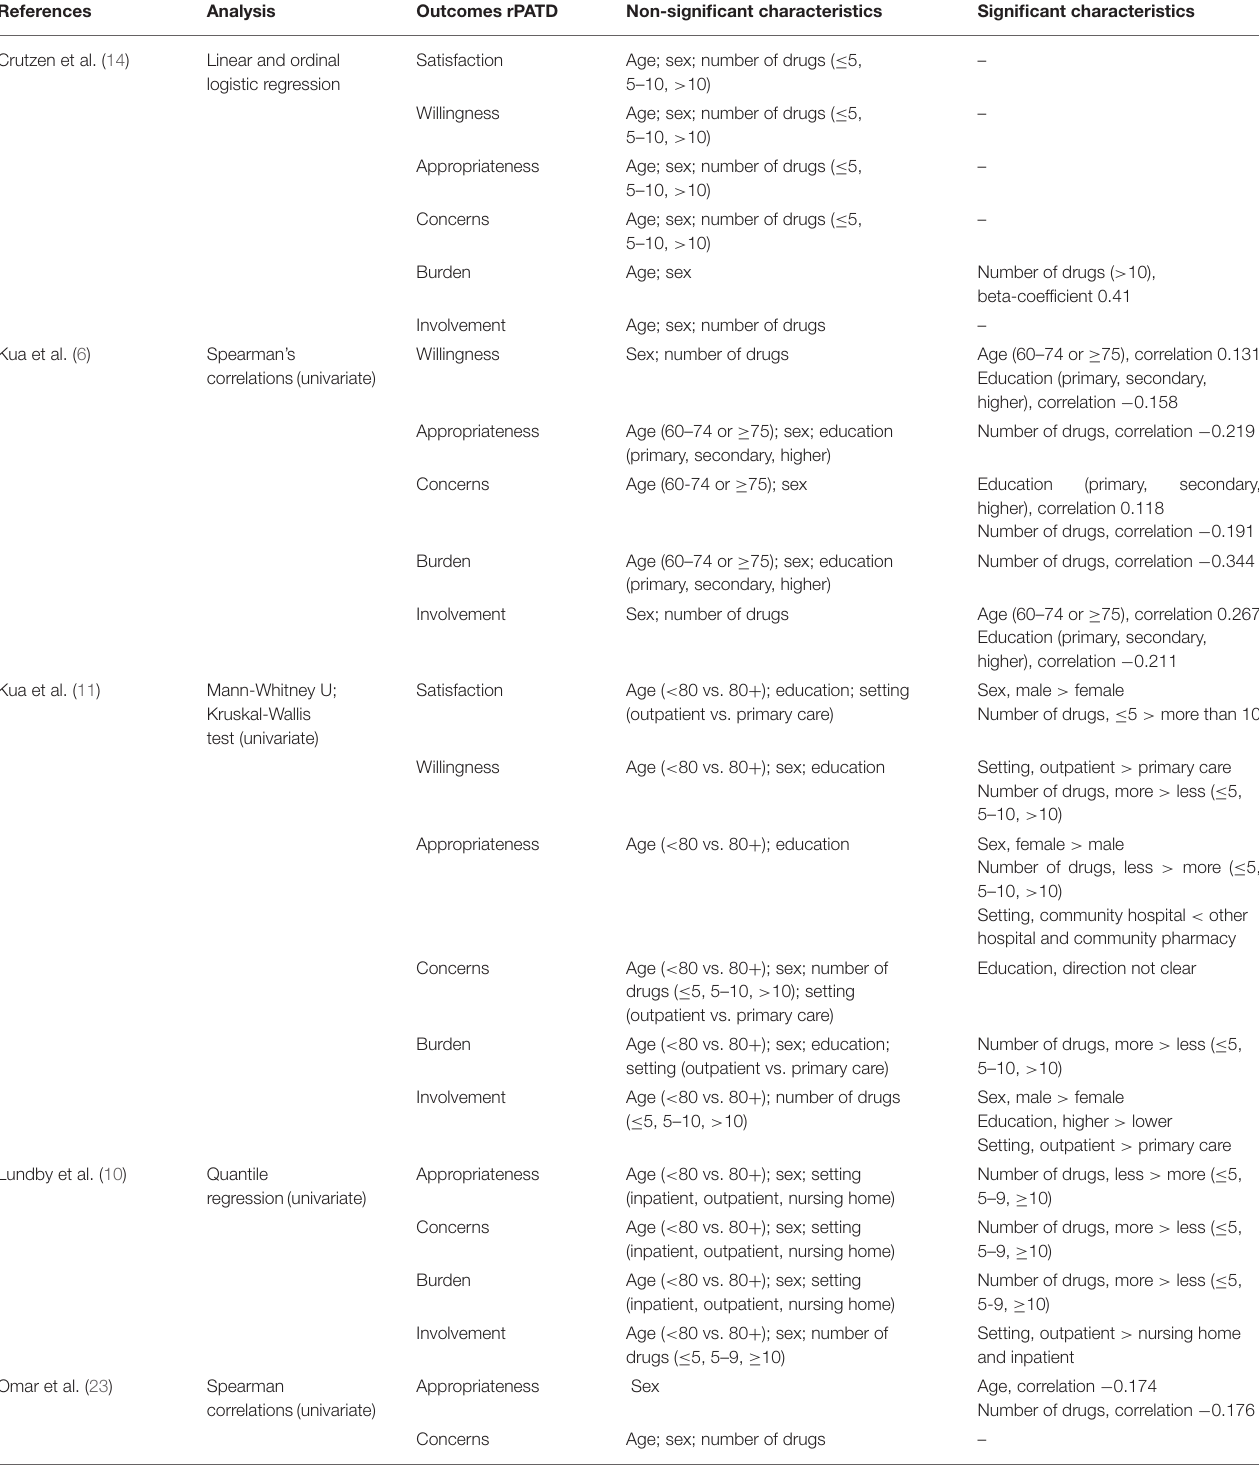
TABLE 1 | Characteristics associated with the two global questions and four factors outcomes from the revised Patients’ Attitudes Towards Deprescribing (rPATD)